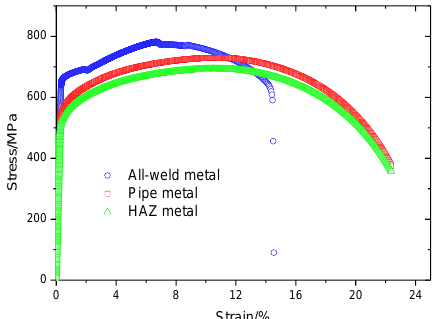
Figure 4. True stress-strain curve for pipe metal by DIC, HAZ metal and all-weld-metal. Hardness data was obtained using a Vickers hardness tester(Kbprueftechnik,